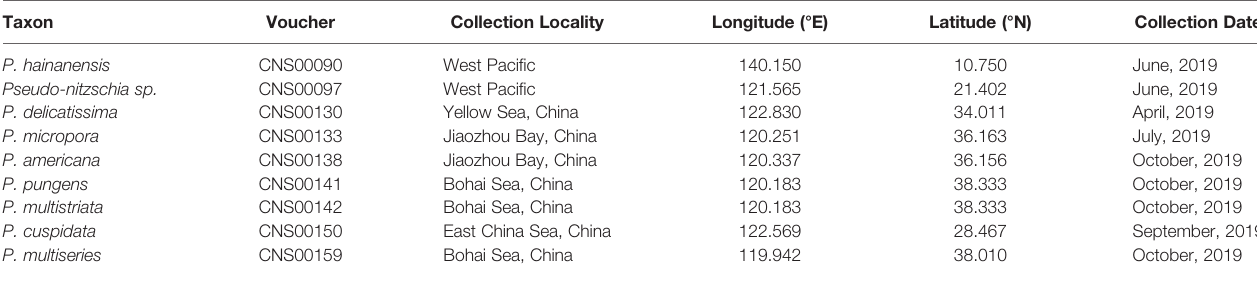
TABLE 1 | Collection locality and date of nine Pseudo-nitzschia strains.